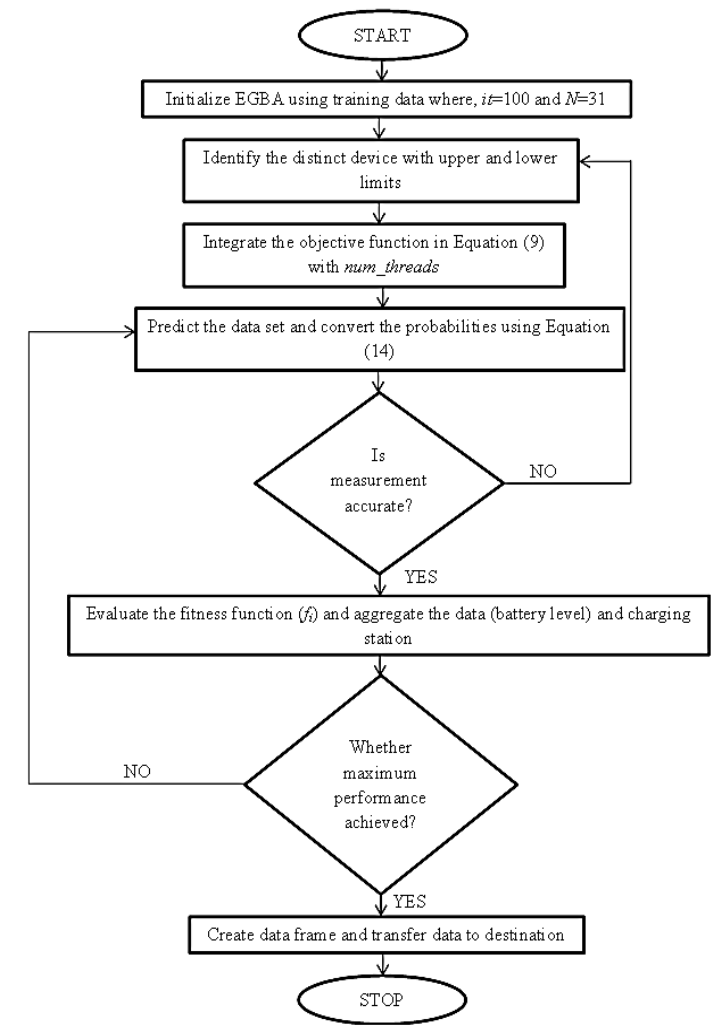
Figure 1. Flow chart of Extended Gradient Boosting Algorithm (EGBA).